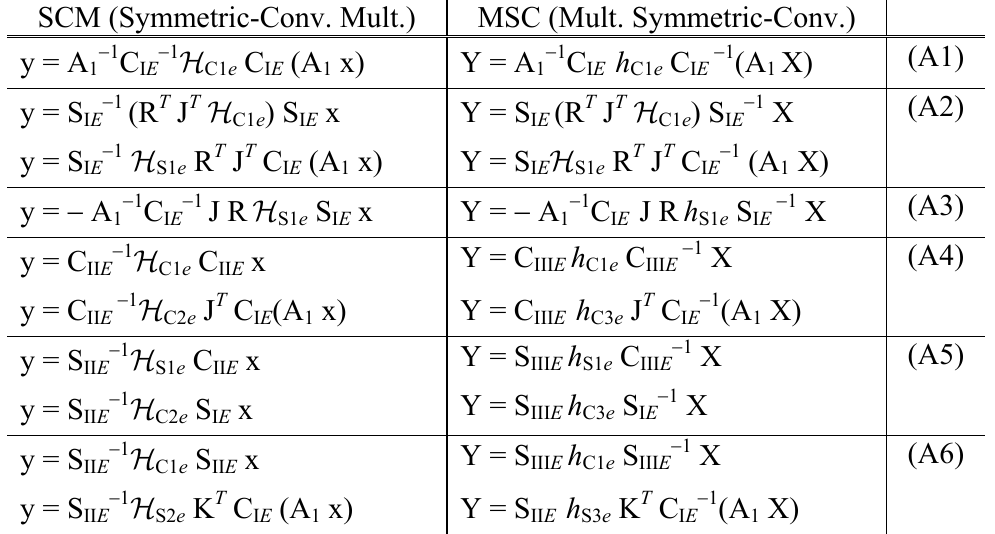
Table 3. 20 of 40 types of SCM and MSC properties for the DTTs, M = 2 N